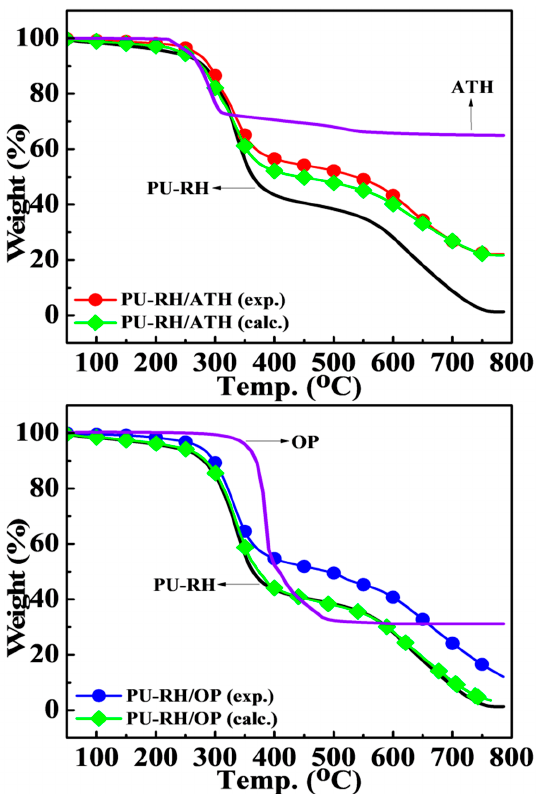
Figure 4. Comparison of the experimentally determined TG curves and values calculated using the additive rule for the PU–RH/FR mixtures under the air atmosphere.